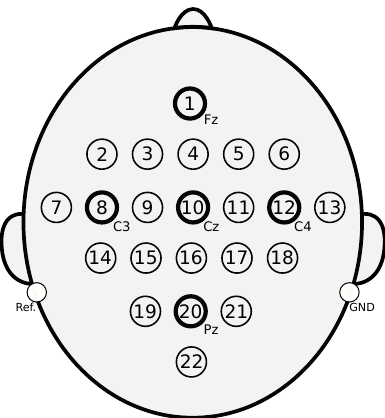
Figure 2. Distribution of electrodes for EEG signals